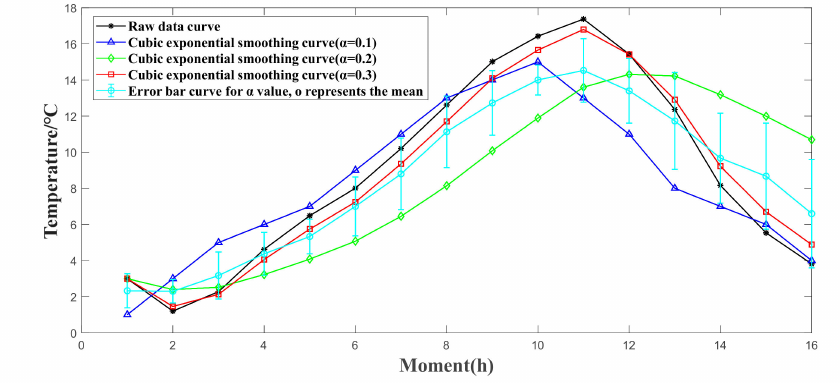
Figure 3. Effect of raw data and three exponential Figure 3. E ff ect of raw data and three exponential smoothing.